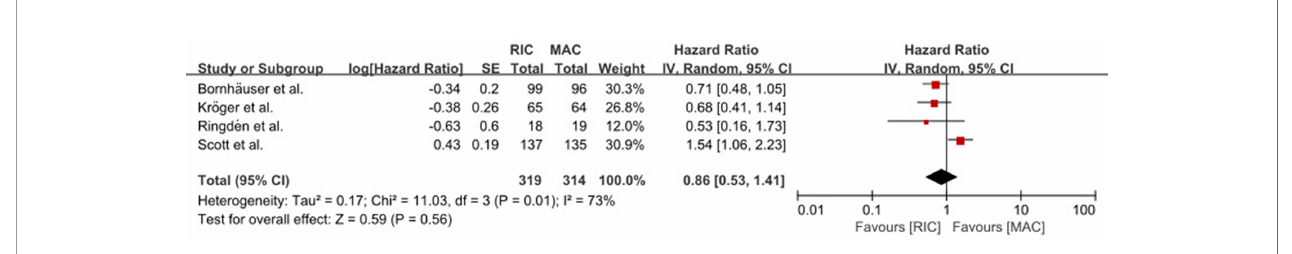
FIGURE 3 | Result of meta-analysis of long-term OS data. The forest plot showed that RIC had the same long-term OS as TBI/Bu-based MAC. OS, overall survival; RIC, reduced intensity conditioning; MAC, myeloablative conditioning; TBI, total body irradiation;